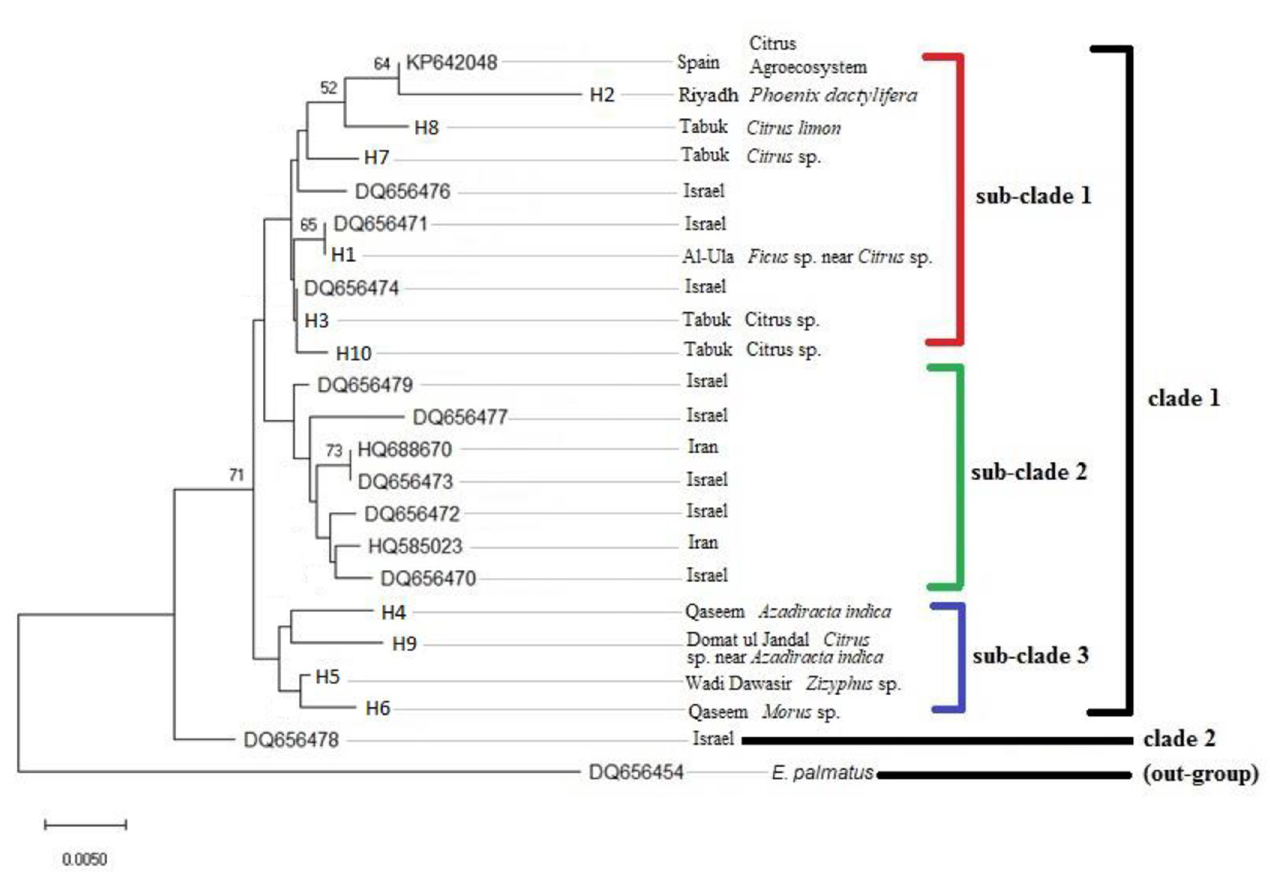
Fig 3. NJ tree based on ITS2 sequences obtained from 10 E . orientalis haplotypes recovered from different hosts and regions in Saudi Arabia, and 12 homologous ITS2 sequences retrieved from NCBI-GenBank database. The ITS2 sequence DQ656454 E . palmatus , a genetically close species to E . orientalis , was used as an out-group taxon. Numbers on the tree branches are bootstrap values obtained from 1000 replicates.